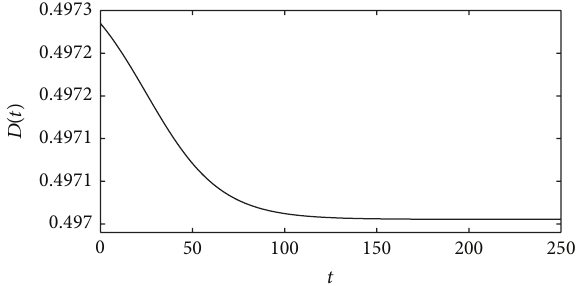
Figure 2: The optimal cost sharing rate of the LSI.